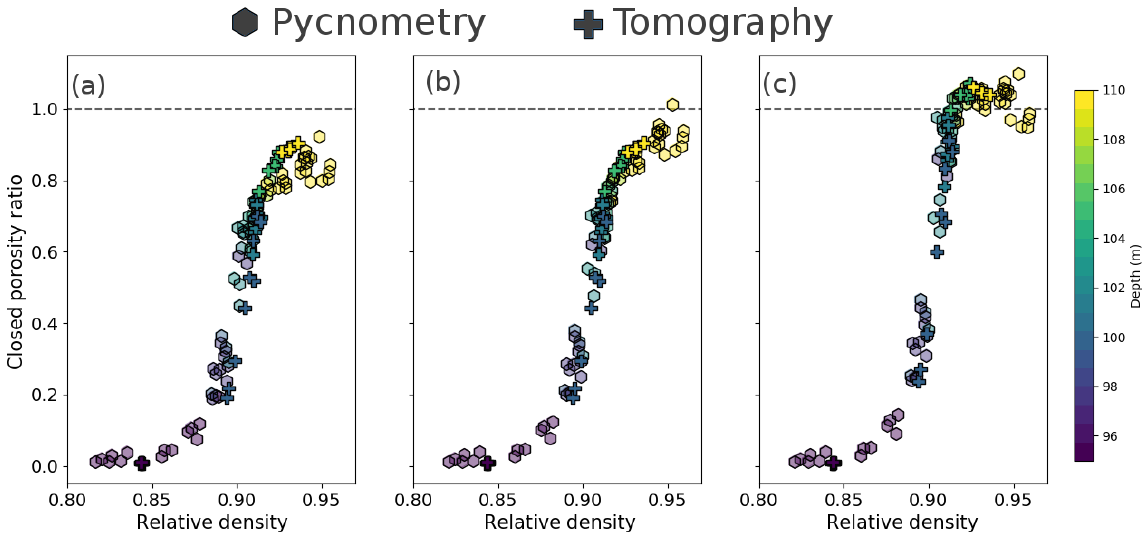
Figure 2. Closed porosity ratio against relative density. (a) Raw closed porosity ratios obtained from pycnometry and tomography. (b) Py- cnometry results corrected for volume overestimation and unaltered tomography data. (c) Pycnometry and tomography data corrected for cut-bubble effect. Colors stand for the depth of the sample. Note that the color scale has been limited to the range 95 to 110m to emphasize the middle of the trapping